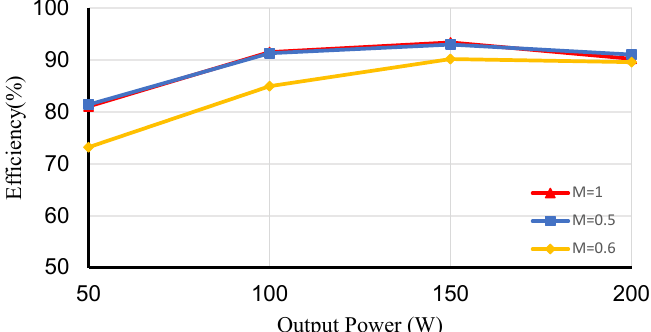
Figure 18. Measured efficiency at different load levels with different M in forward